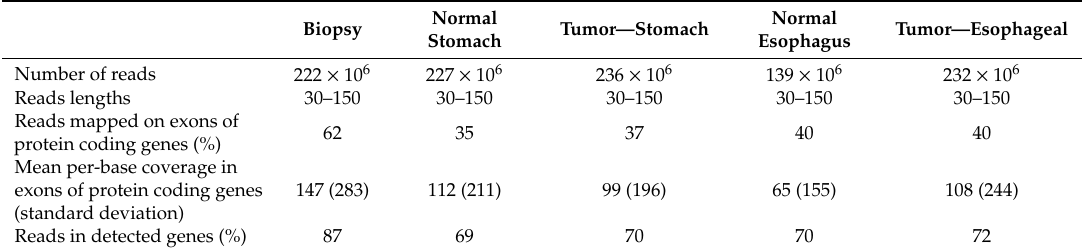
Table 1. Statistics of genomic data obtained using sequencing-based cancer diagnostics platform